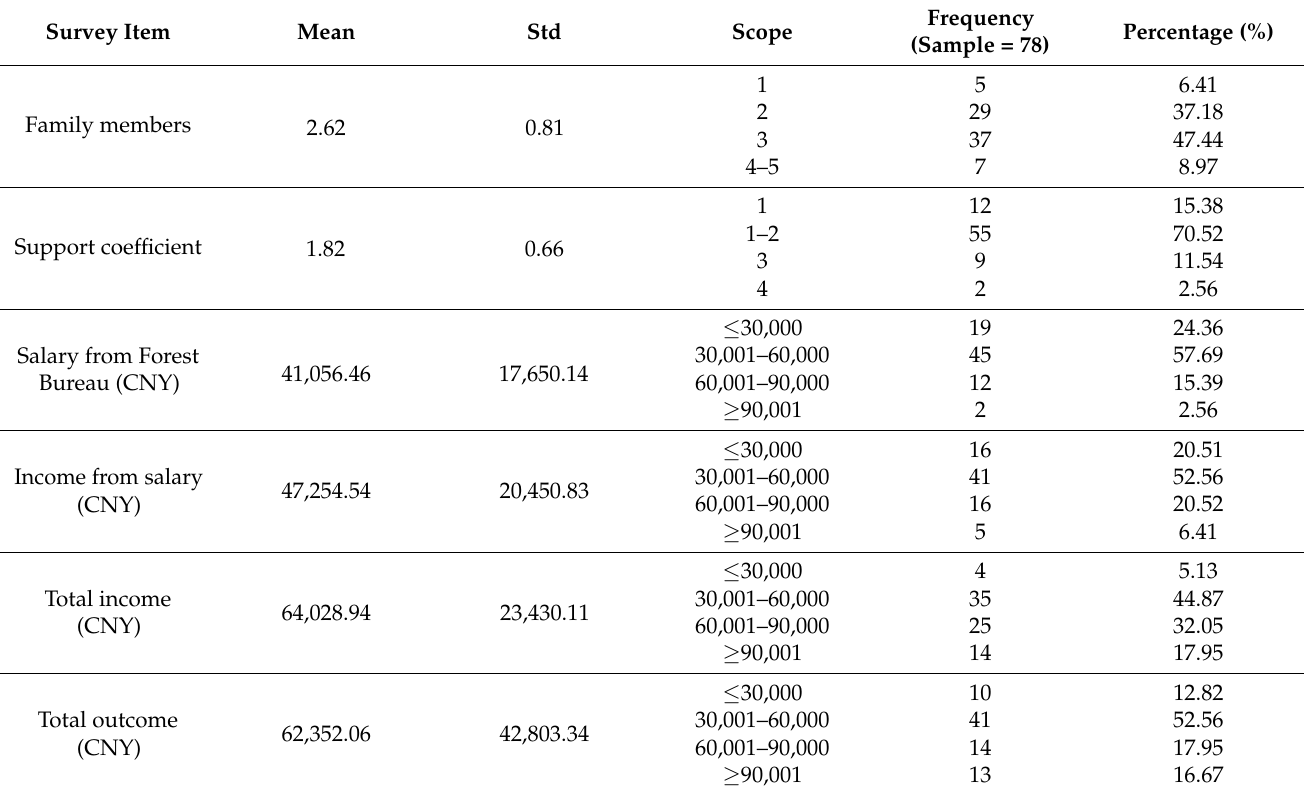
Table 3. Family characteristics of ecological service